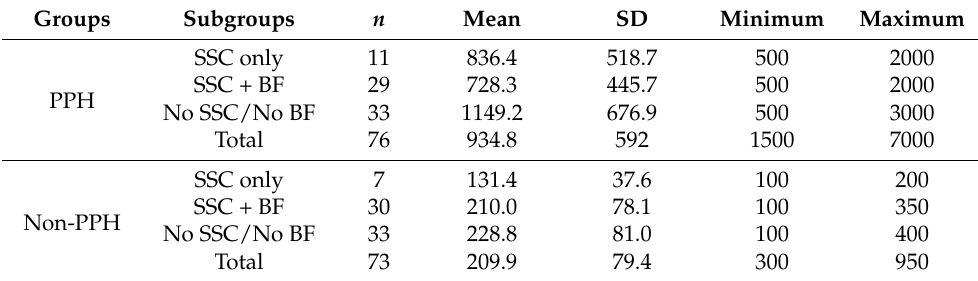
Table 5. Amount of EBL in Women with PPH and Women without